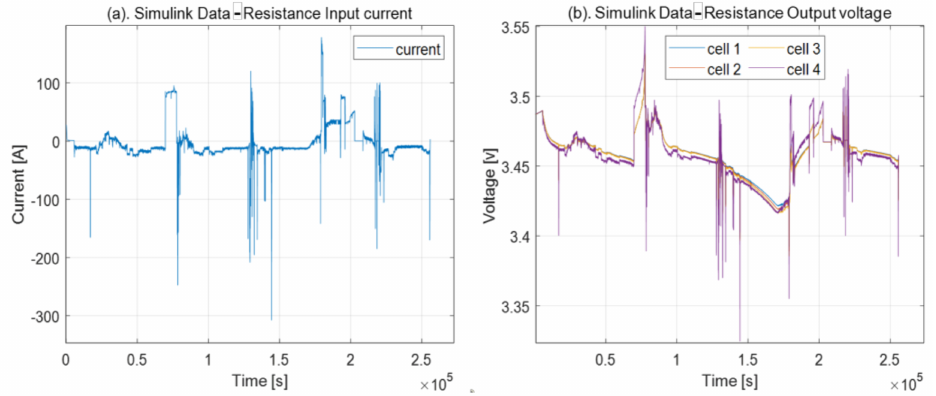
Figure 8. ( a ) Input current ( left ) and ( b ) output voltage ( right